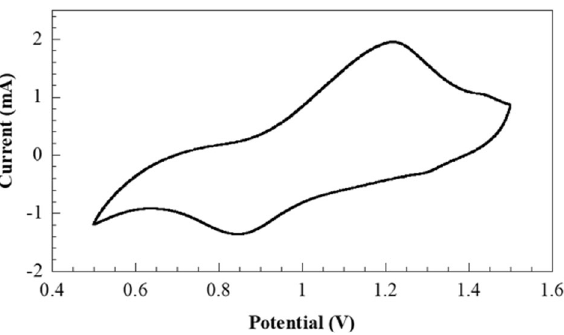
Figure 10. Curve present cyclic voltammetry profile at scan rate 1 mV s −1 of full cell NVO//Zn battery.